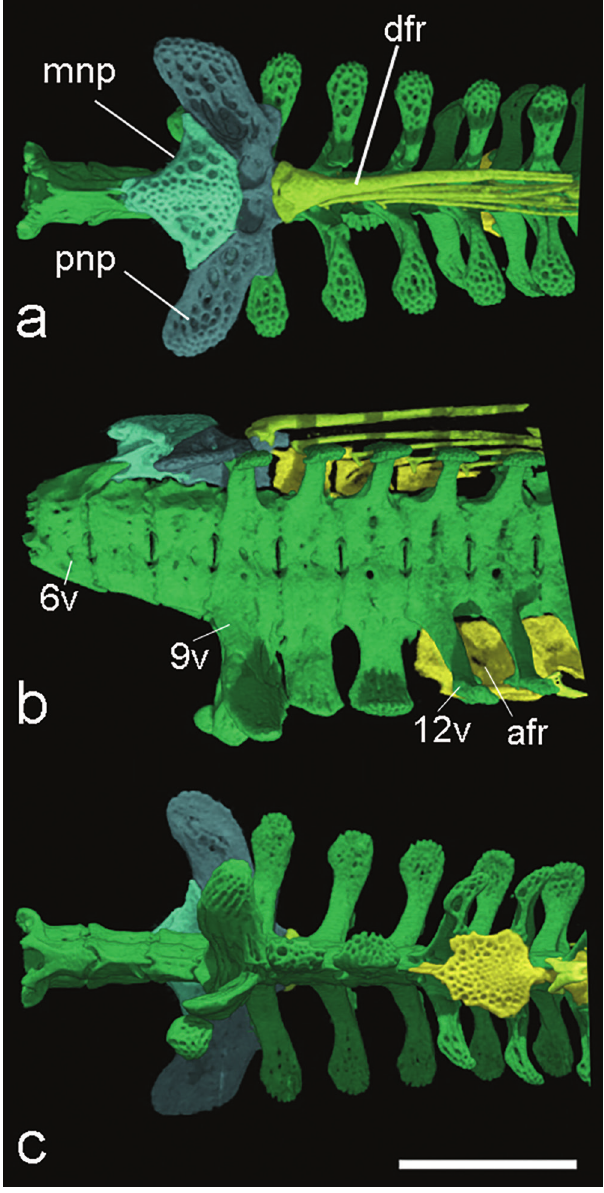
Fig. 9. HRXCT model of anterior vertebrae and associated dorsal and anal fin structures of Hoplomyzon cardosoi , MCNG 375, holotype, 18.5 mm SL. a. Dorsal view; b. lateral view, and c. ventral view (anterior portion towards left). 6v: vertebrae 6; 9v: vertebrae 9; 12v: vertebrae 12; afr: anal-fin radials; dfr: dorsal-fin rays; mnp: middle nuchal plate; pnp: posterior nuchal plate. Scale bar = 1 mm. Color in alcohol. Head and body yellowish pale, with scattered brownish chromatophores dispersed mostly on dorsal portions. Dark chromatophores concentrated on internarial and interorbital regions and also on dorsal portion over dorsolateral vertebral processes. All fins hyaline. Pale coloration perhaps due to postmortem bleaching during storage in poor quality alcohol and long exposure to